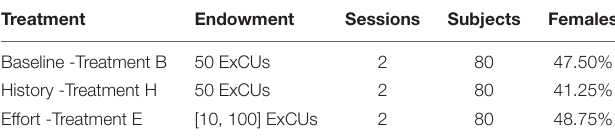
nor reciprocity is a possible result under the assumptions of rationality and selfishness of both players.